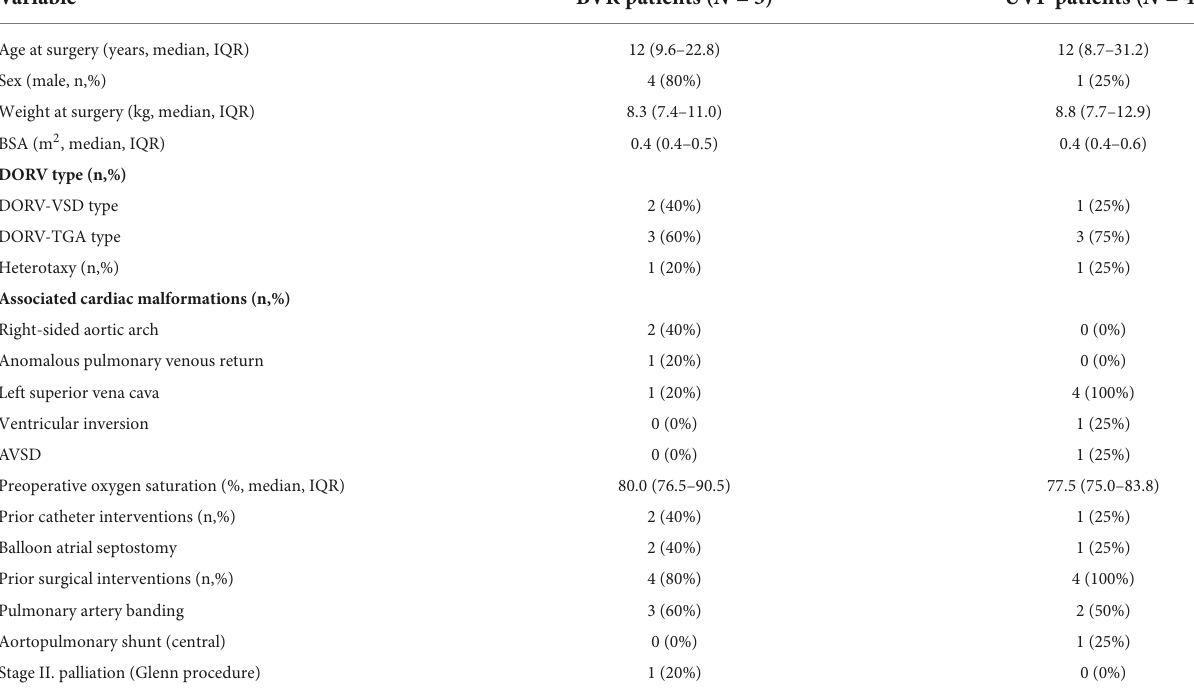
TABLE 1 Baseline